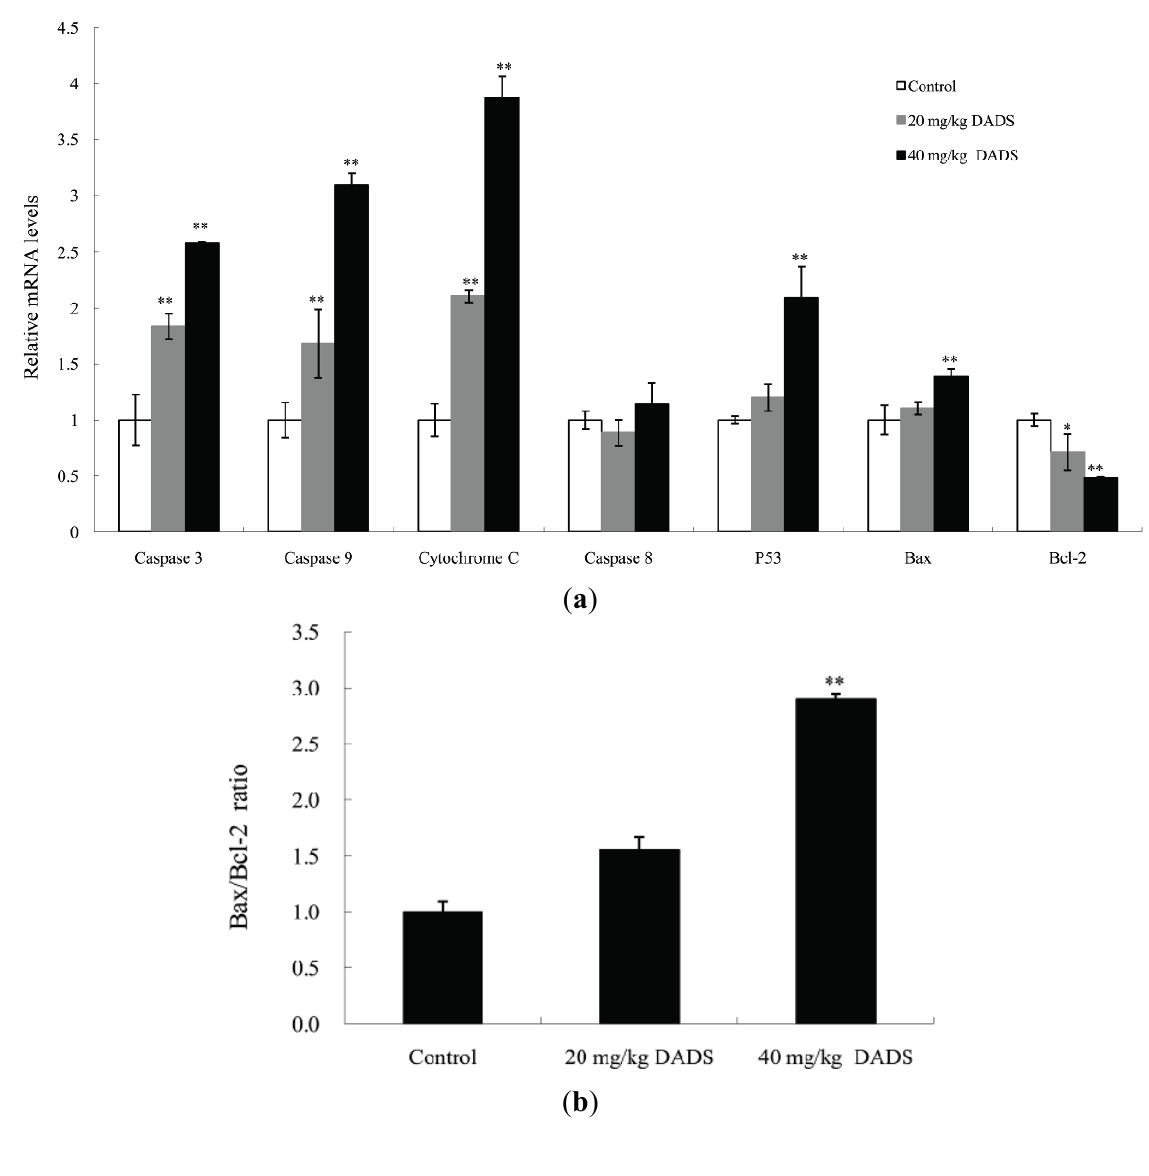
Figure 6. DADS activated mitochondria-dependent pathway and shift in Bax/Bcl-2 ratio in ECA109 xenograft tumors. The mRNA and protein expression levels of caspase-3, caspase-8, caspase-9, cytochrome C, Bax, Bcl-2 and p53 from the negative control group, 20 mg/kg DADS group and 40 mg/kg DADS group were assessed by qPCR and western blot. ( a ) The mRNA expressions of caspase-3, caspase-8, caspase-9, cytochrome C, Bax, Bcl-2 and p53; ( b ) Bax/Bcl-2 ratio; ( c ) Representative blots; Densitometric analysis was made on the expressions of p53 (7F5) ( d ); active caspase-3 ( e ); active caspase-9 ( f ) and cytochrome C ( g ). β -Actin was used as the loading control. Data are expressed as the mean ± SD from three independent experiments (* p < 0.05, ** p < 0.01 compared with the control